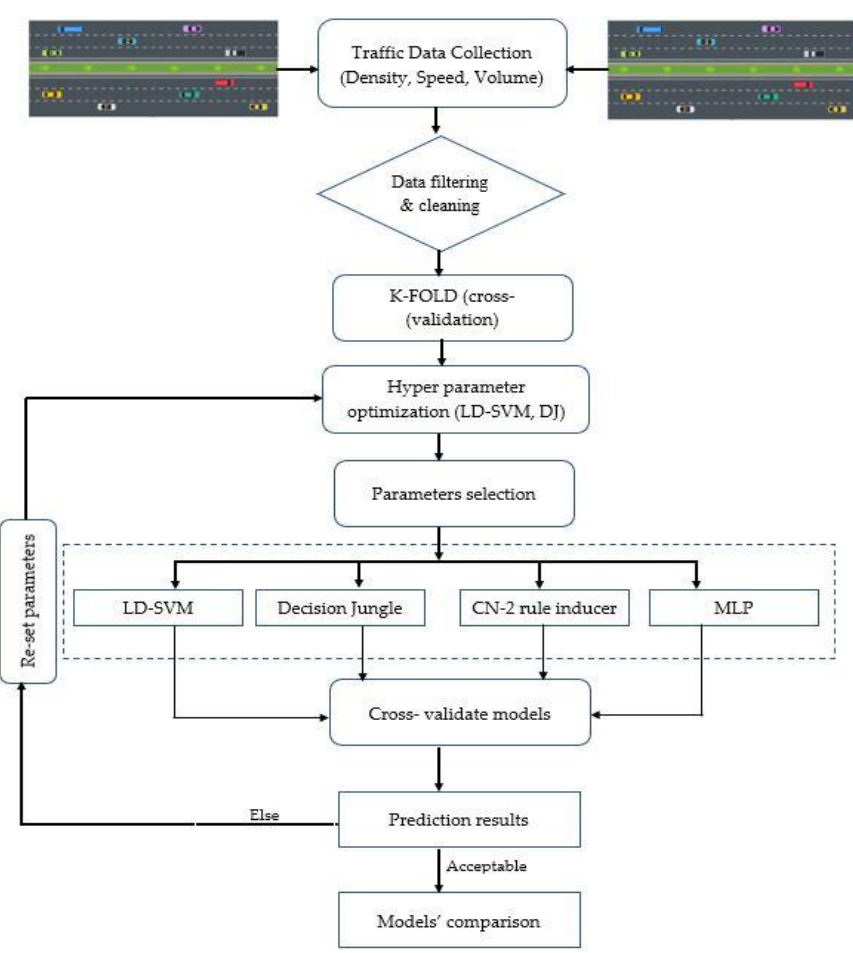
Figure 5. Proposed methodology for the study.